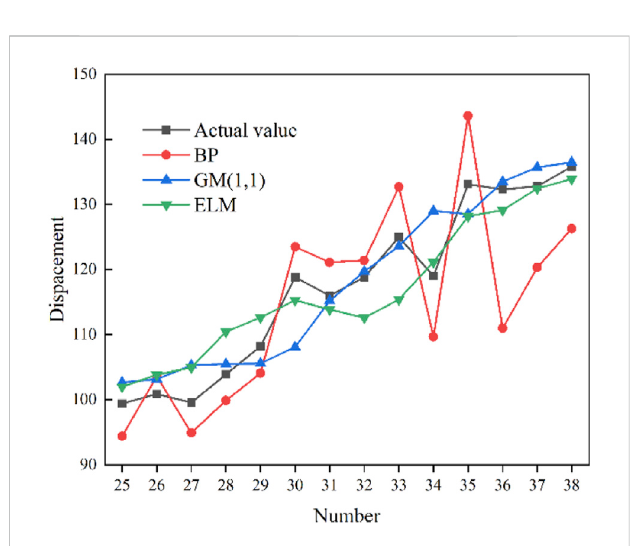
FIGURE 4 Comparison of single model prediction results.